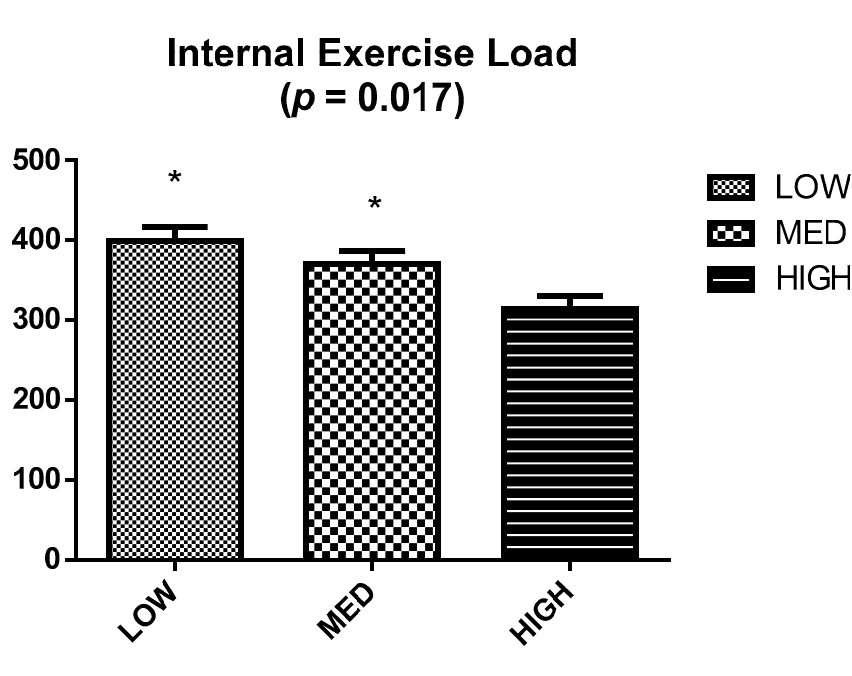
Figure 2. Internal exercise load by training impulse (TRIMP) for each group during trail marathon. * Significant di ff erences in terms of HIGH using Mann Whitney u test ( p < 0.05).